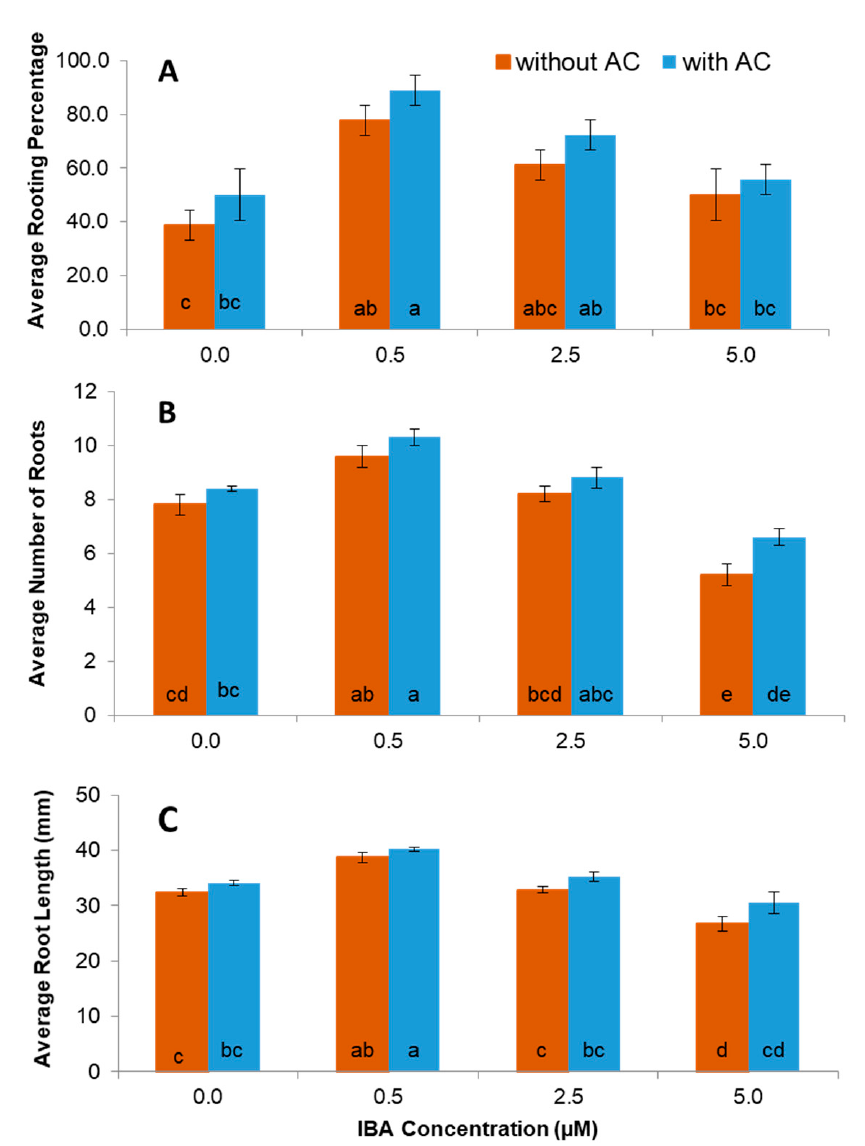
Figure 4. Effect of different concentrations of IBA (indole-3-butyric acid) added to Murashige and Skoog basal (MS) medium on the percentage of rooting ( A ), number of roots ( B ) and root length ( C ) of shoots developed from in vitro grown nodal explants of ‘ Vrinda ’ compared to control. Means from all the treatments were compared with each other using Tukey’s test and data represent mean ± standard error from 30 explants per treatment and three replications. Vertical bar with same letters indicates no significant difference between treatments at ( p > 0.05).